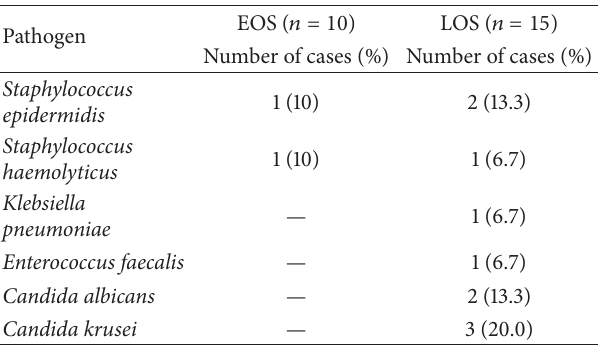
Table 2: Pathogenic spectrum of blood-culture proven sepsis